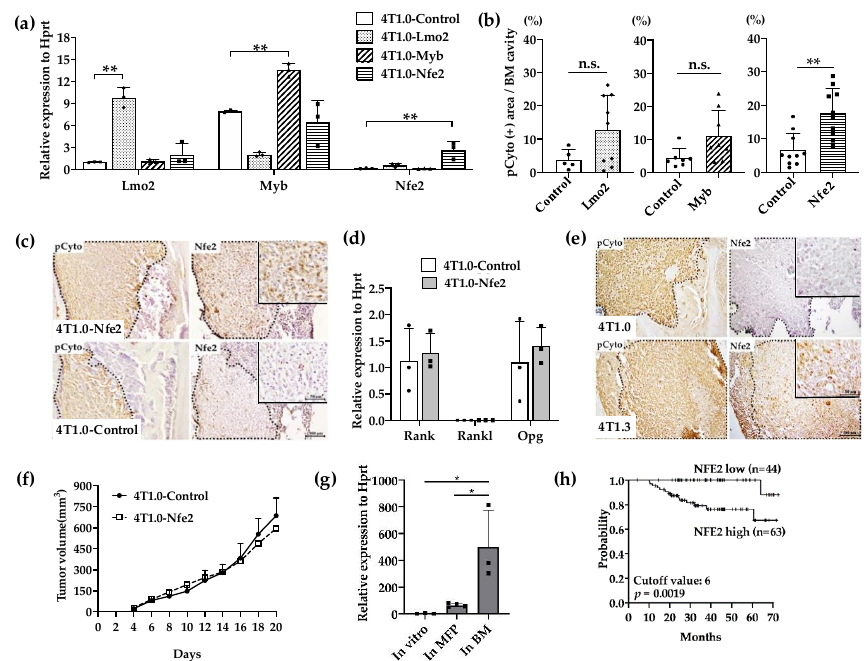
Figure 3. ( a ) Expression levels of transcription factor mRNA expression in the used transfectants. 4T1.0 cells were transfected with each transcription factor-expressing or control vector and total RNAs were extracted from the resultant transfectants. The mean and SD values were calculated from 3 independent experiments. ** p < 0.01. ( b ) Intraosseous tumor formation of Lmo2 -, Myb -, or Nfe2 -overexpressing 4T1.0 cell lines. Lmo2 -, Myb - or Nfe2 -expressing or control vector-transfected 4T1.0 cells (5.0 × 10 3 cells) were injected into tibiae of mice. Seven days after the inoculation, tibiae were removed and subjected to anti-pan cytokeratin antibody staining to detect tumor foci formation. All values represent mean + SD ( n = 5 to 9). ** p < 0.01, n.s., not significant. ( c ) Immunohistochemical analysis of Nfe2 -expressing or control vector-transfected 4T1.0 cells in a bone cavity. Tibiae were obtained from mice 7 days after intraosseous injection of Nfe2-expressing or control vector-transfected 4T1.0 cells and were subjected to anti-pan cytokeratin or anti-NFE2 antibodies staining. Pan-cytokeratin-positive tumor areas are demarcated by dot lines. Representative images from 5 independent mice are shown here. Insets indicate enlarged area of tumor foci. Scar bars, 100 µ m in main images, 50 µ m in insets. ( d ) Determination of mRNA expression level of m Rank , Rankl , or Opg in Nfe2 -expressing or control vector-transfected 4T1.0 cells. Total RNAs were extracted either from Nfe2 -expressing or control vector-transfected 4T1.0 cells cultured in vitro. All values represent mean + SD ( n = 3). ( e ) Immunohistochemical analysis of 4T1.0 or 4T1.3 cells in a bone cavity. Tibiae were obtained from mice 7 days after intraosseous injection of 4T1.0 or 4T1.3 cells and were subjected to anti-pan cytokeratin or anti-NFE2 antibodies staining. Pan-cytokeratin-positive tumor areas are demarcated by dot lines. Representative images from 5 independent mice are shown here. Insets indicate enlarged area of tumor foci. Scar bars, 100 µ m in main images, 50 µ m in insets. ( f ) Tumor growth rates of Nfe2 -expressing or control vector-transfected 4T1.0 cells upon their injection into mammary fat pads. Nfe2 -expressing or control vector-transfected 4T1.0 cells (1.5 × 10 5 ) were injected into mammary fat pads and tumor growth was determined at the indicated time points. All values represent mean + SD ( n = 5). ( g ) Expression level of Nfe2 mRNA in 4T1.3 cells, which were cultured in vitro, grew at mammary fat pads or in a bone marrow cavity. Total RNAs were extracted from 4T1.3 cells, which were cultured in vitro (In vitro), were isolated from primary tumor at day 9 after orthotopic injection (In MFP) or from a bone marrow cavity at day 7 after intraosseous injection (In BM). All values represent mean + SD ( n = 3). * p < 0.05 ( h ) E ff ects of NFE2 expression level on the prognosis of breast cancer patients. Overall survival of patients with breast cancer (GSE16446) was analyzed based on NFE2 expression level by analyzing the Kaplan–Meier Plotter